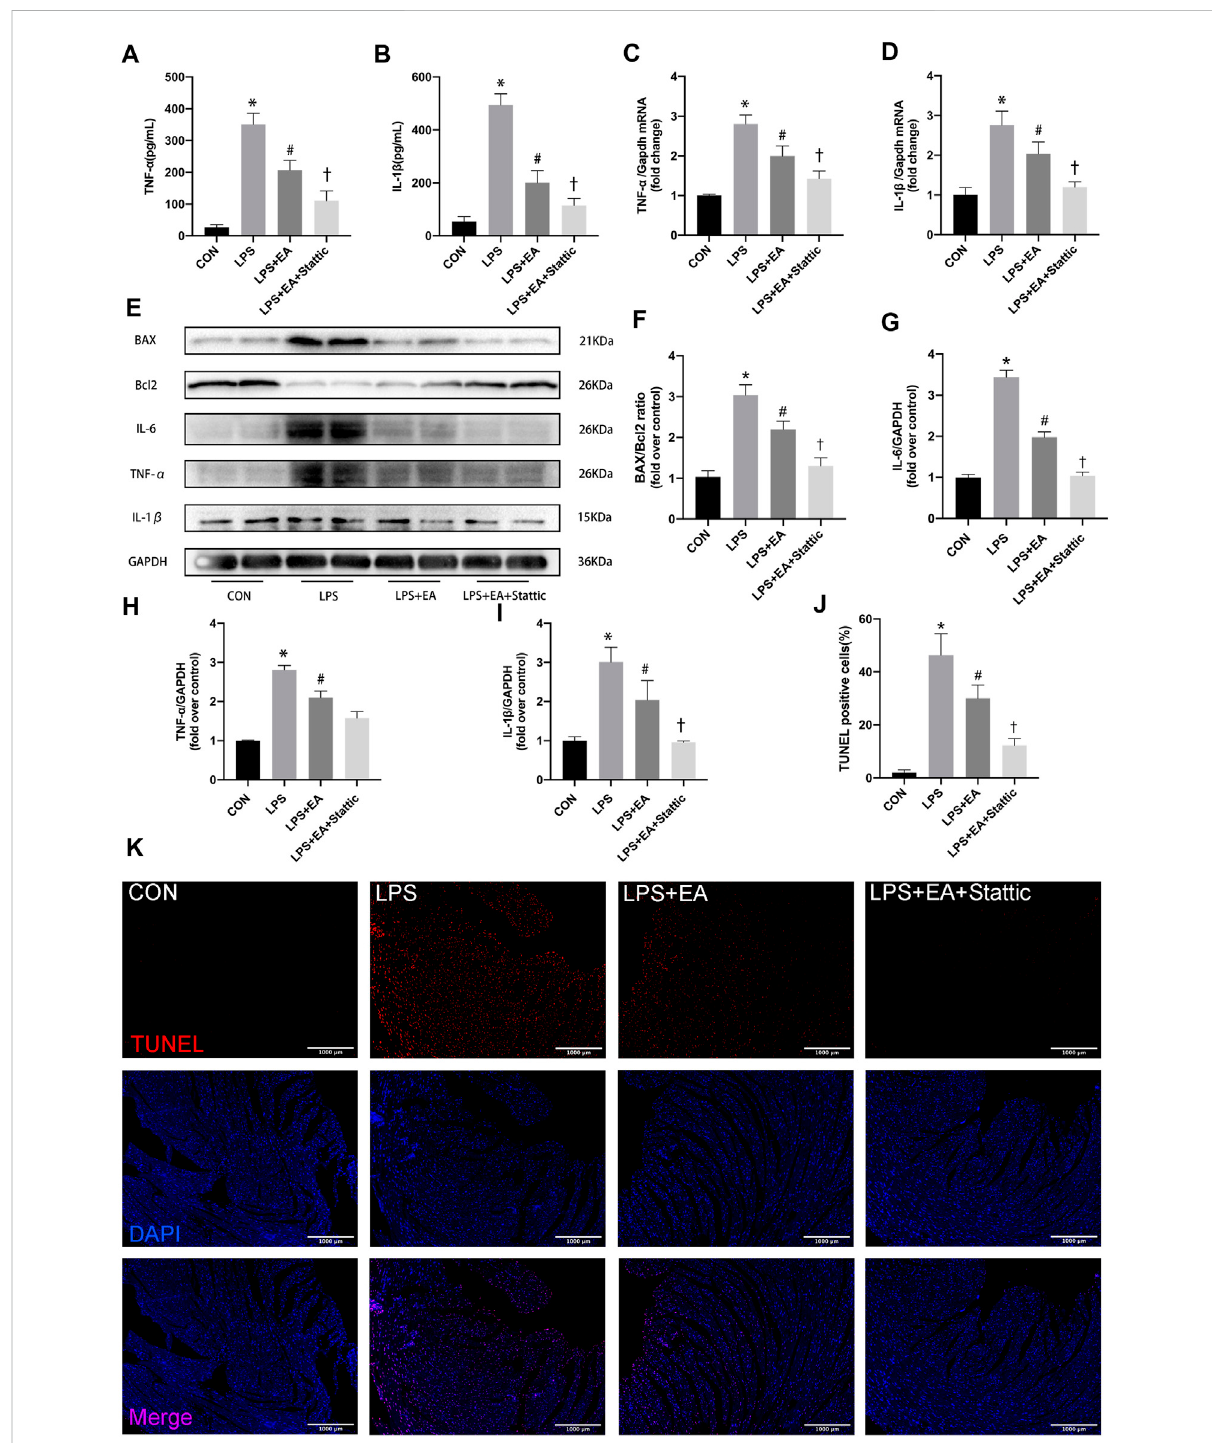
Stattic inhibited STAT3 and enhanced the anti-in fl ammatory and anti-apoptosis effects in EA pre-treatment sepsis mice. (A,B) Serum concentrations of TNF- α and IL-1 β . (C,D) mRNA expression of Tnf- α and Il-1 β . (E) Representative images of western blots forBAX,Bcl2, IL-6, TNF- α , IL-1 β , and GAPDH. (F) BAX/Bcl2 ratio. (G – I) Quantitative results of IL-6, TNF- α , and IL-1 β . (J – K) TUNEL staining and Quantitative analysis, apoptosis positivecells(red),nuclei(blue).N=4pergroup.EA,electroacupuncture;LPS,lipopolysaccharide.* p < 0.05vs.controlgroup, # p < 0.05vs.LPS group, † p < 0.05 vs. LPS + EA